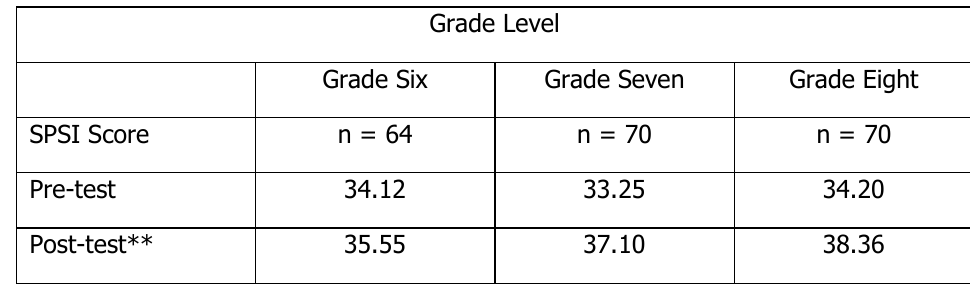
Means of SPSI Scores by Grade